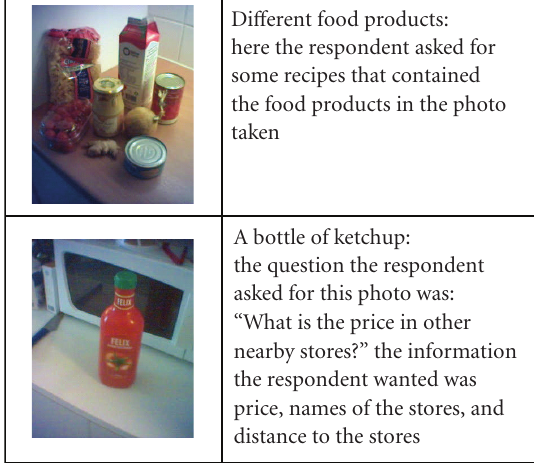
Figure 2: Examples of image queries.